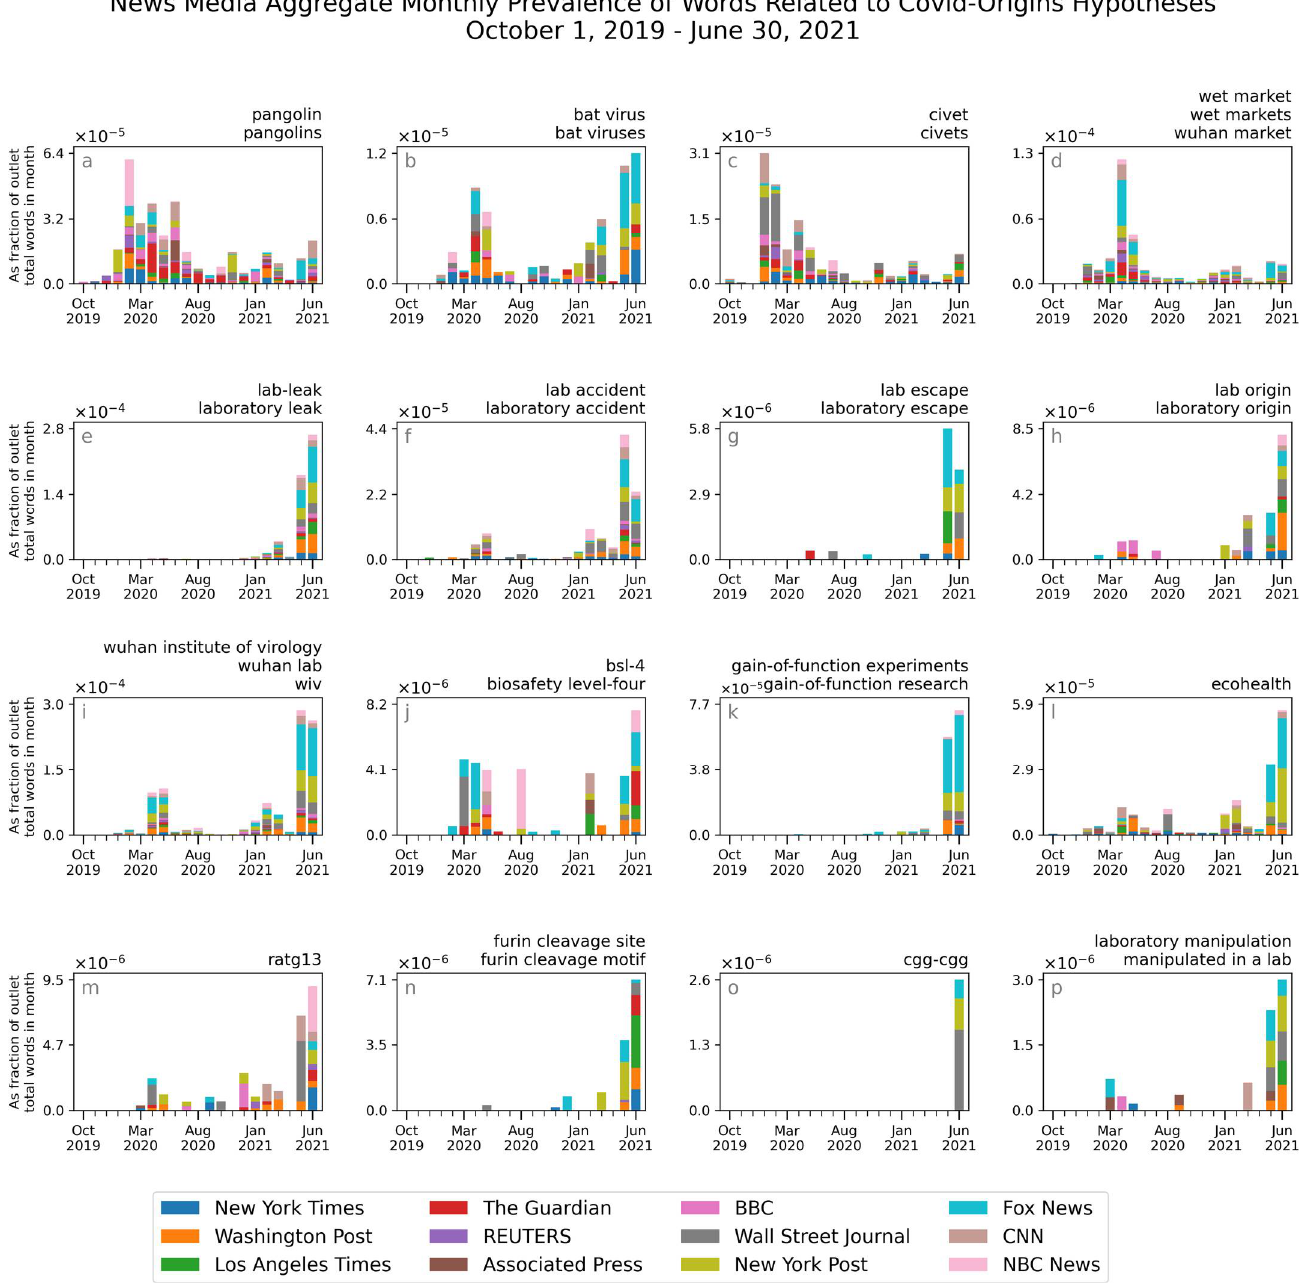
Figure 2. Monthly frequency of terms related to the two competing hypotheses about COVID-19 origins: natural emergence (first row) and lab-leak (second, third and fourth rows).